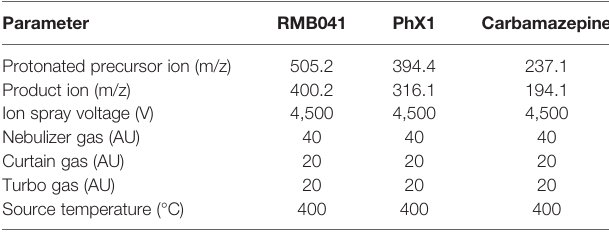
TABLE 2 | MS/MS settings used for analysis of carbamazepine, RMB041, and PhX1 in mouse organ